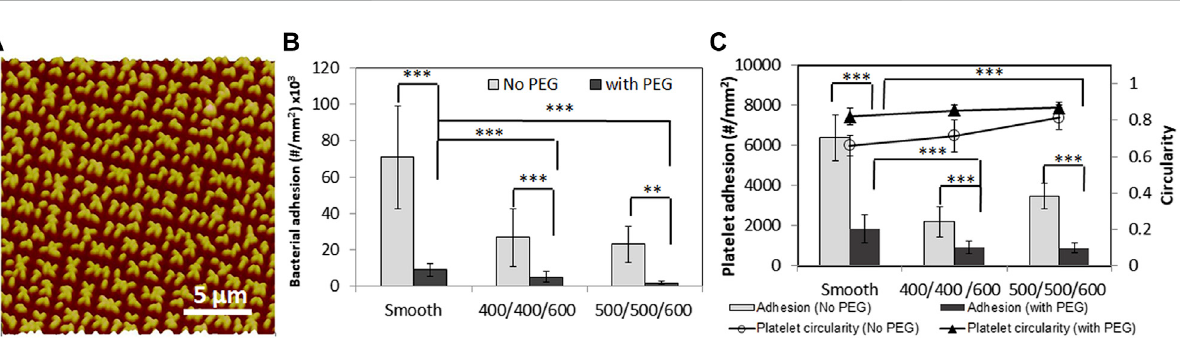
FIGURE 4 AFM topography image of PEG modi fi ed on textured PU surfaces with 500/500/600 nm pillar pattern (A) . S. epidermidis RP62A adhesion (B) andplateletadhesionandactivation(indicatedbyplateletcircularity) (C) onsmooth,texturedwith400/400/600,500/500/600